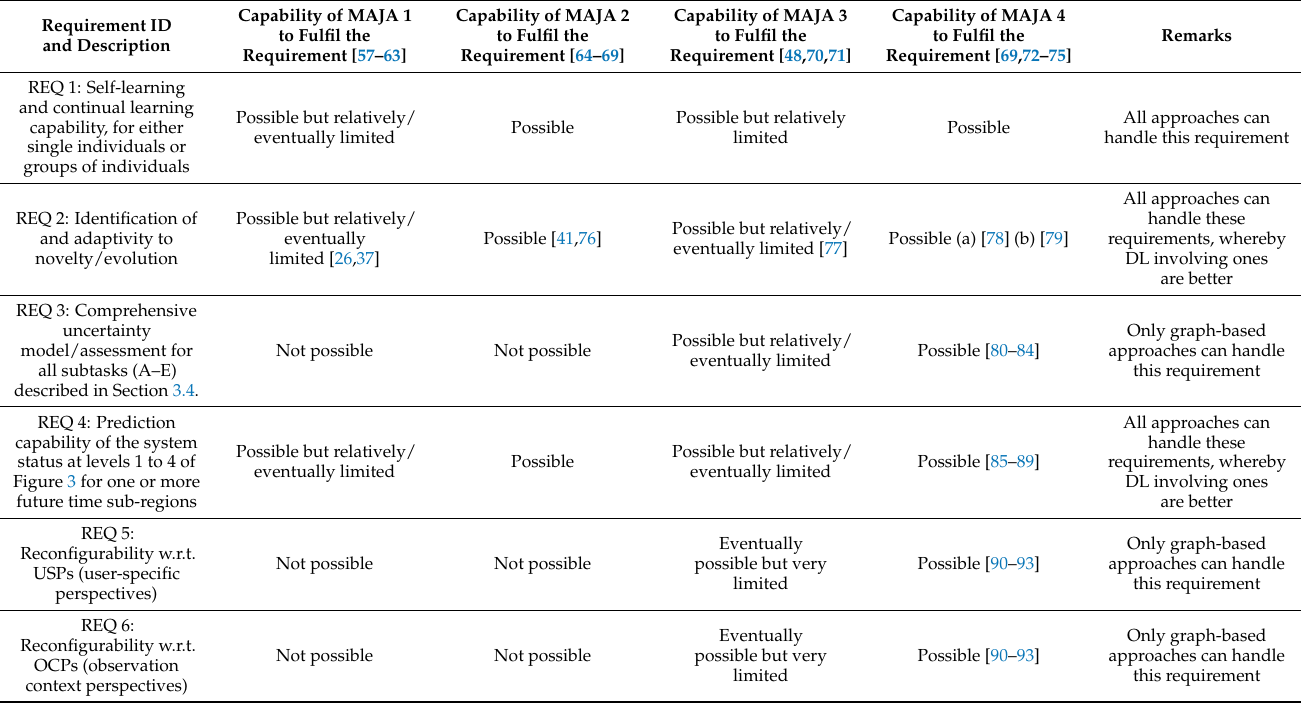
Table 8. A deep and comparative analysis of how far the four major approaches are capable or not of modeling and address the tough specifications expressed in the requirements dossier of the target context of “monitoring a human in